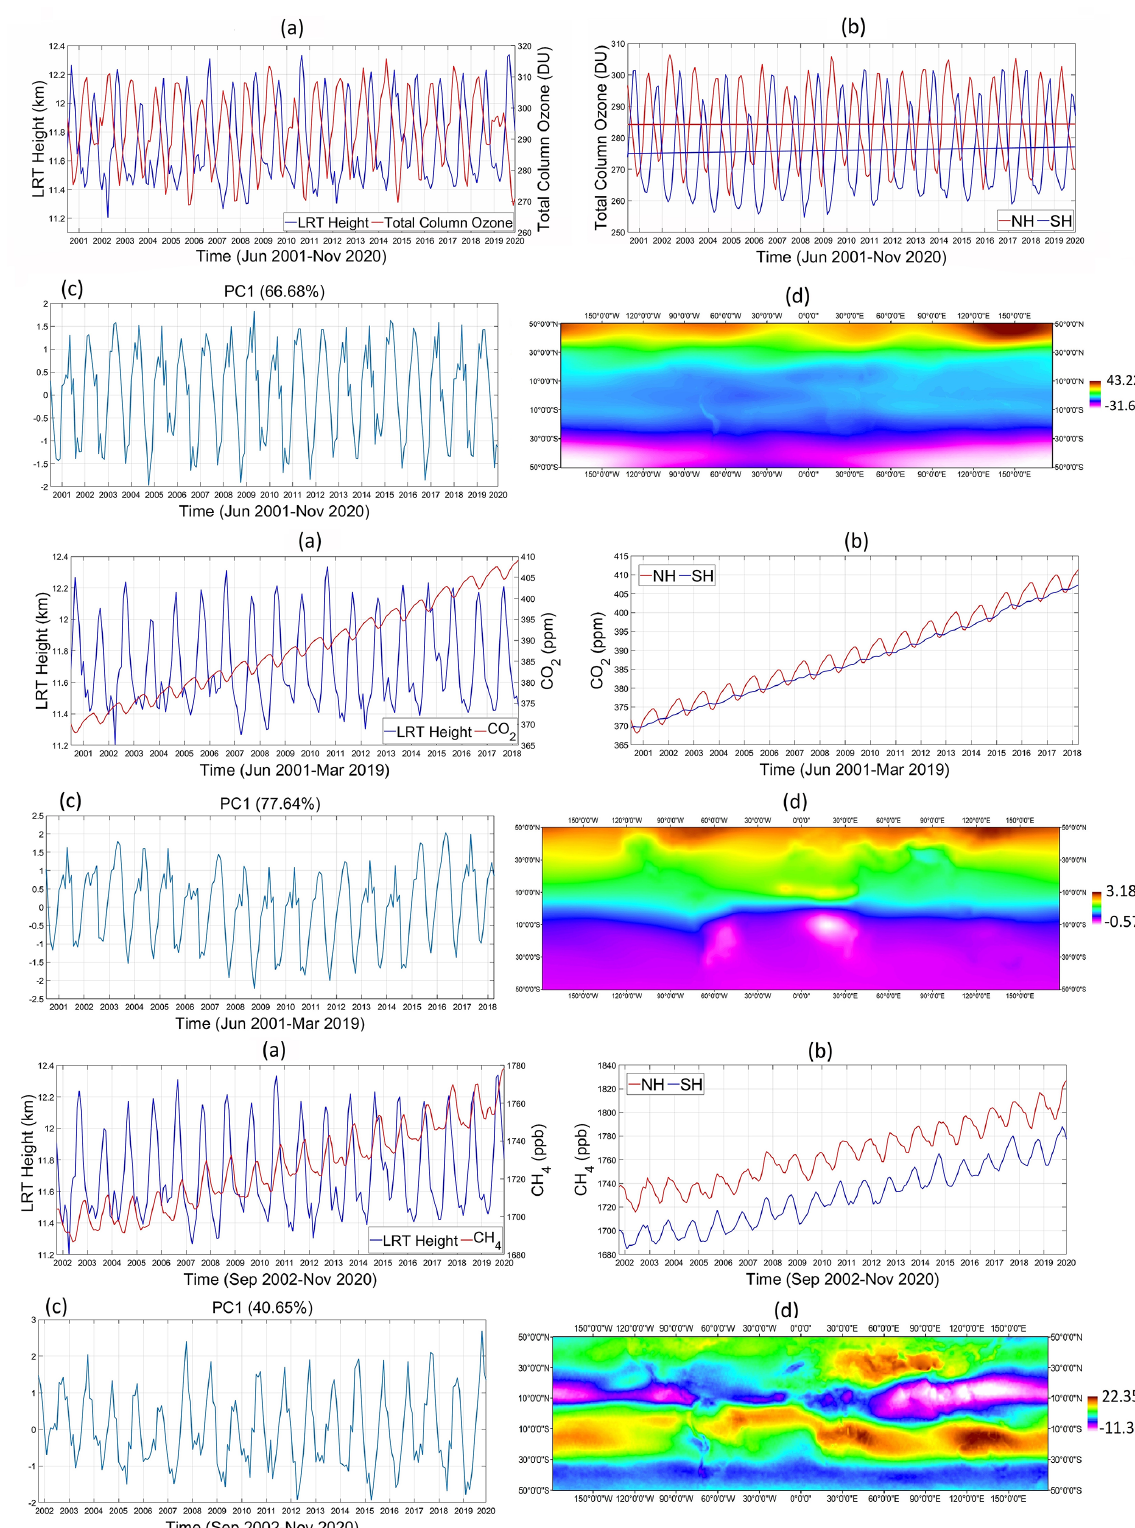
Figure 9. TCO (top), CO 2 (middle), and CH 4 (bottom) results. In (a) are global time series against GNSS LRT height; (b) temporal time series in the NH and the SH; (c) temporal variability given by PCA1 and (d) the spatial variability map given by